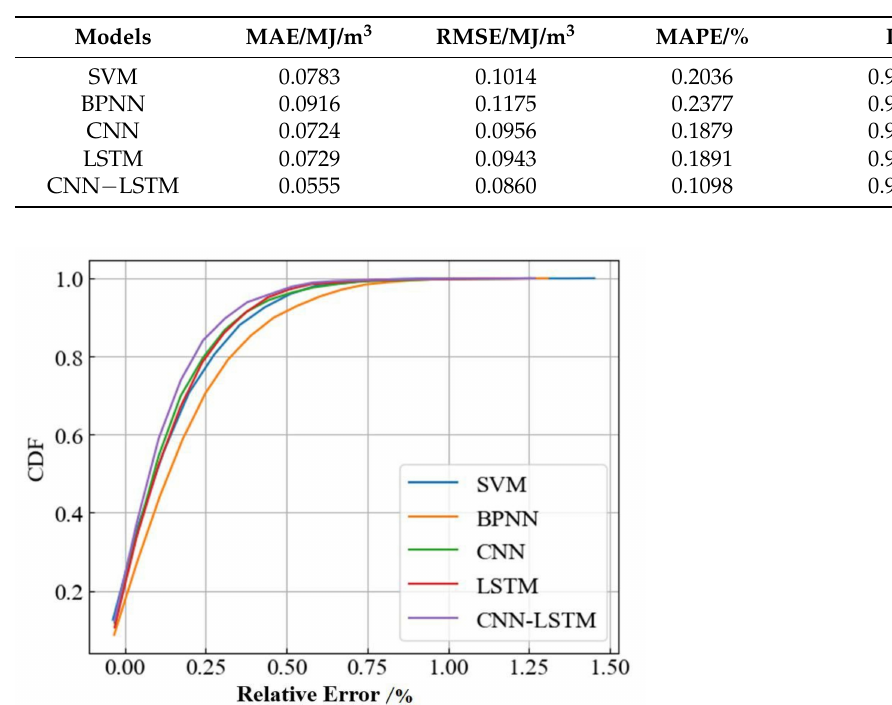
Figure 10. Single − step prediction results of calorific value with different models. Table 4. Comparison for prediction performance with different models.